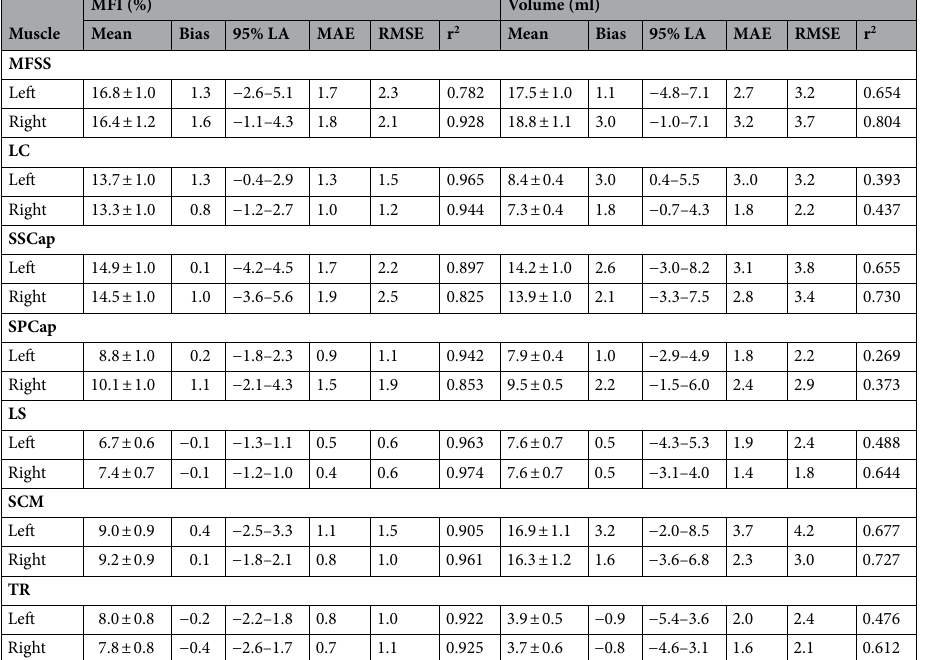
Table 2. CNN MFI and volume accuracy. Bland-Altman plots and Pearson correlations were used to assess the accuracy of the convolutional neural network (CNN) model compared to the ground truth (GT) for muscle fat infiltration (MFI) and muscle volume measures on the testing dataset (n = 18) (Fig. 3, 4). Mean = mean CNN measure ± 1 standard error. Bias = mean difference between CNN and GT. LA = limits of agreement. MAE = mean absolute error. RMSE = root mean squared